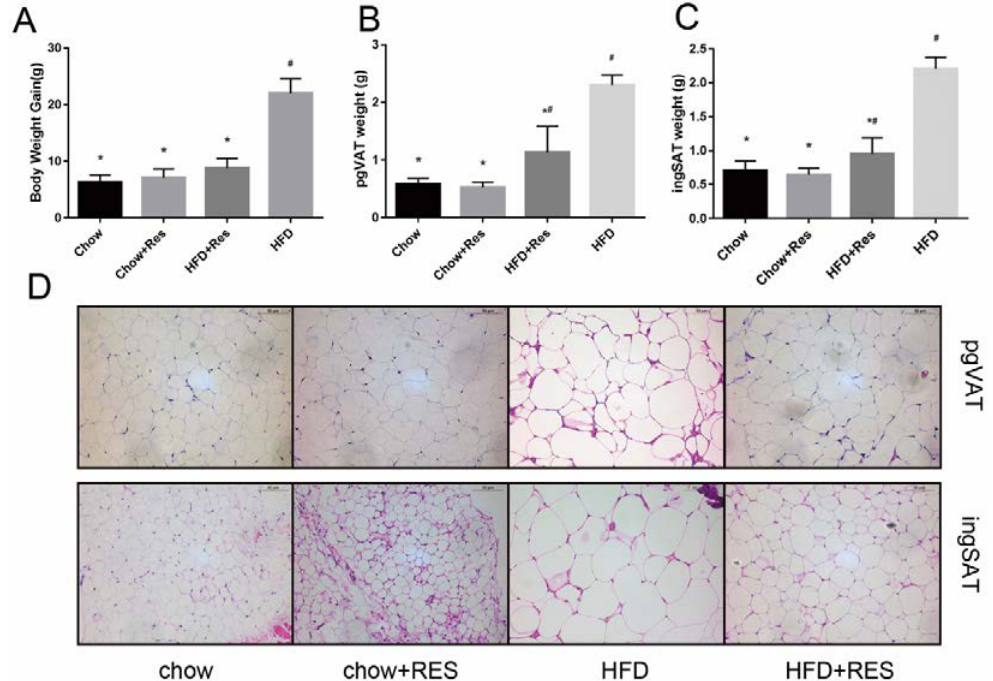
Figure 1. Resveratrol (RES) mitigated high-fat diet (HFD)-induced obesity in mice. Effects of RES treatment on ( A ) body weight gain ( B ) perigonadal visceral adipose tissue (pgVAT) weight ( C ) inguinal adipose tissue (ingSAT) weight and ( D ) perigonadal visceral adipocyte size and inguinal adipocyte size are shown. Scale bar, 50 mm. * p < 0.05; compared with HFD-CT, # p < 0.05; compared with NCD-CT.